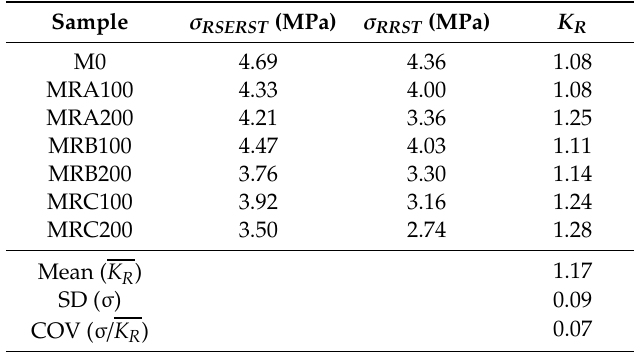
Table 8. K R of the mortars at the cracking time of the RSERST